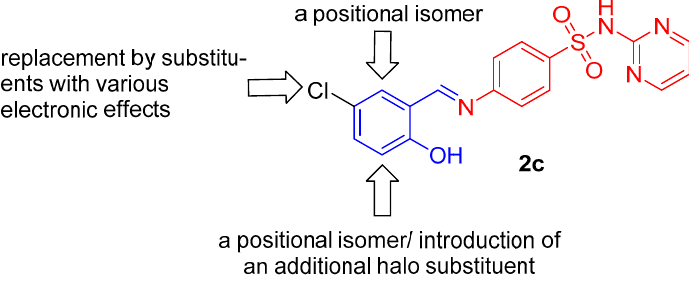
Figure 2. Rational design of novel Schiff bases combining sulfadiazine (red) and salicylaldehyde (blue) scaffolds based on structural modifications of 2c .